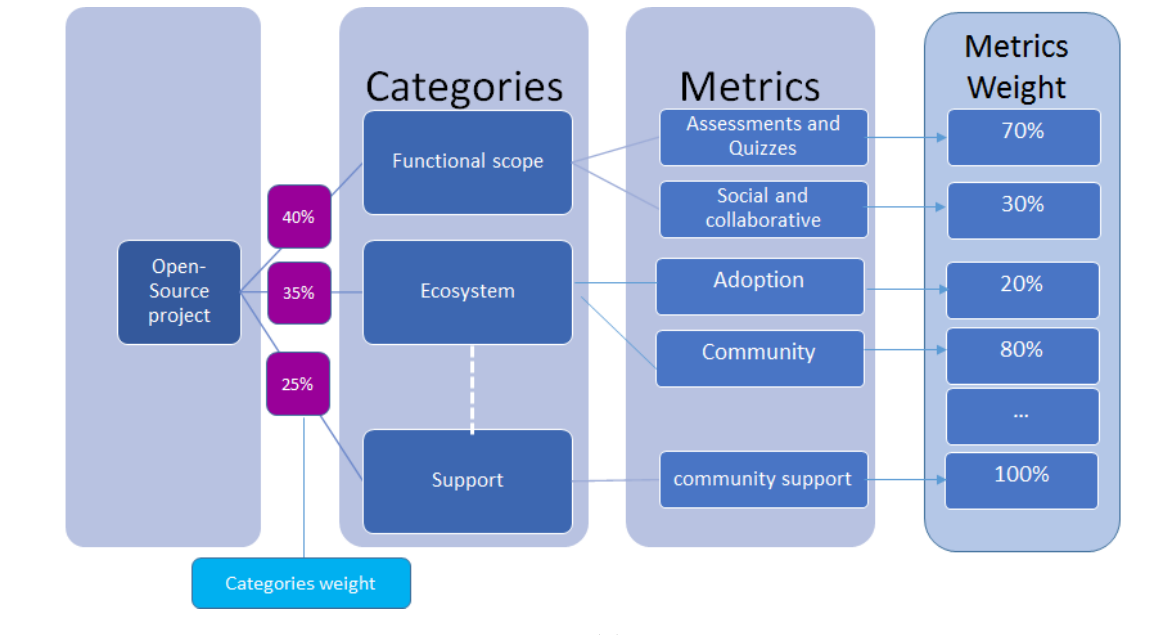
Figure 4. OpenBRR Maturity Model.